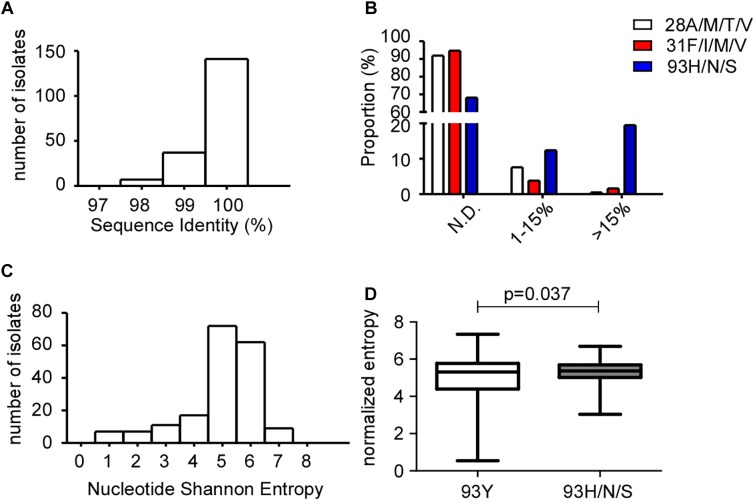
Quasispecies diversity in GT1b samples by NGS. (A) Baseline NS5A sequence identity between NGS and Sanger Sequencing. NGS- and Sanger-derived consensus NS5A sequences from 185 patients samples were aligned and analyzed at the nucleotide level using the BioEdit software. (B) Proportions of patients carrying NS5A RASs 28A/M/T/V, 31F/I/M/V or 93Y/H/S were plotted against the RASs frequency. N.D., not detected. (C) Histograms of baseline NS5A quasispecies diversity, as represented by Shannon entropy in nucleotides. (D) Box plot of normalized entropy in samples with 93Y or 93H/N/S. The unpaired t-test with Welch’s correction was used to assess the statistical significance of differences between the median Shannon entropy.